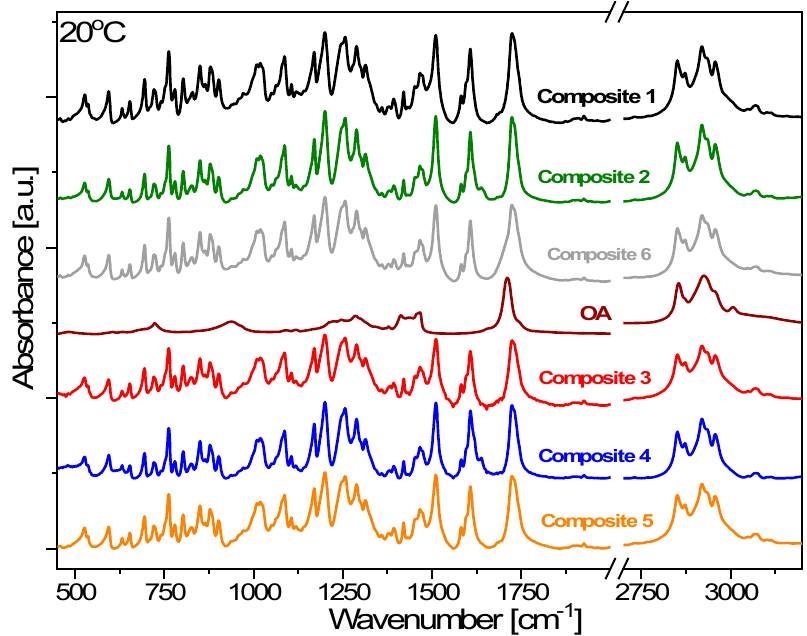
Figure 16. FTIR spectra of Composites 1–6 and oleic acid obtained at 20 °C.